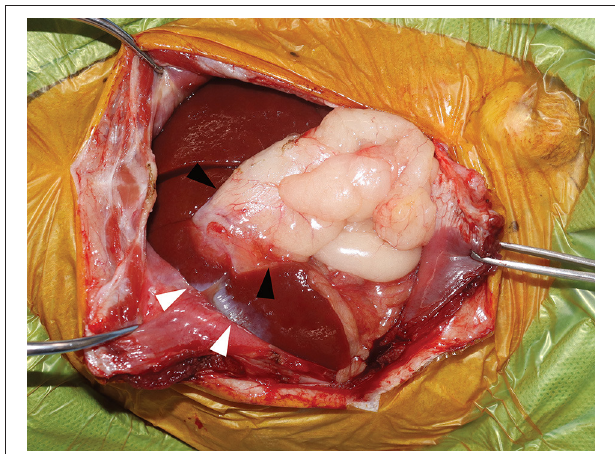
FIGURE 5 | Intraoperative findings. Image showing severe adhesion between the right medial lobe of the liver and the abdominal wall (white arrow-head) and between the gallbladder and omental fat (black arrow-head).